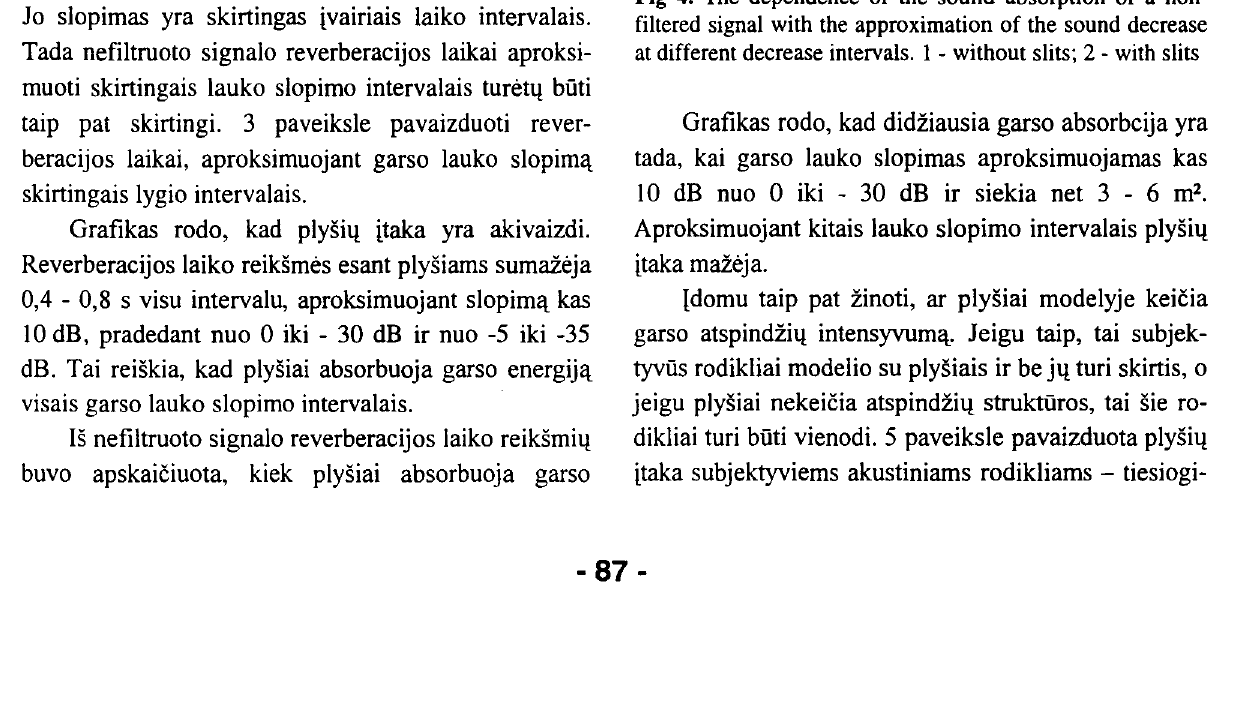
Fig 4. The dependence of the sound absorption of a non filtered signal with the approximation of the sound decrease at different decrease intervals. 1 - without slits; 2 - with slits